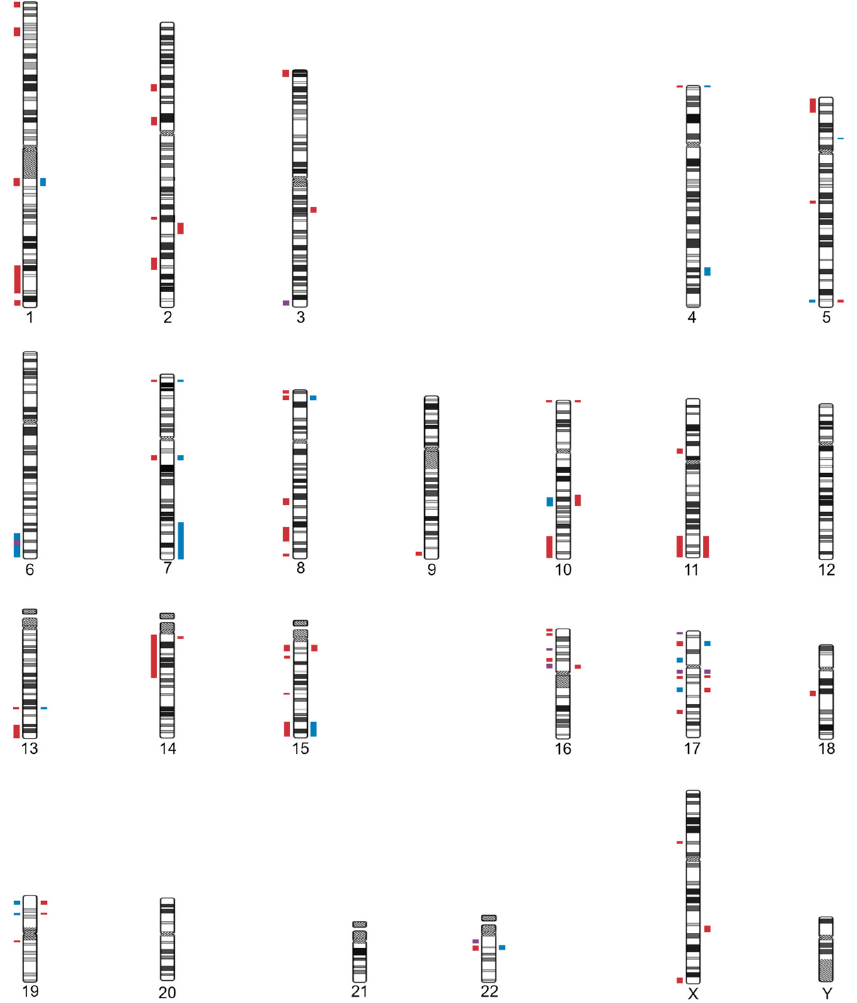
Figure 2. Map of the loci with CNV syndromes–deletions in red, duplications in blue, or both in purple–associated with microcephaly– represented on the left side of the chromosomes –or macrocephaly– represented on the right side of the chromosomes.